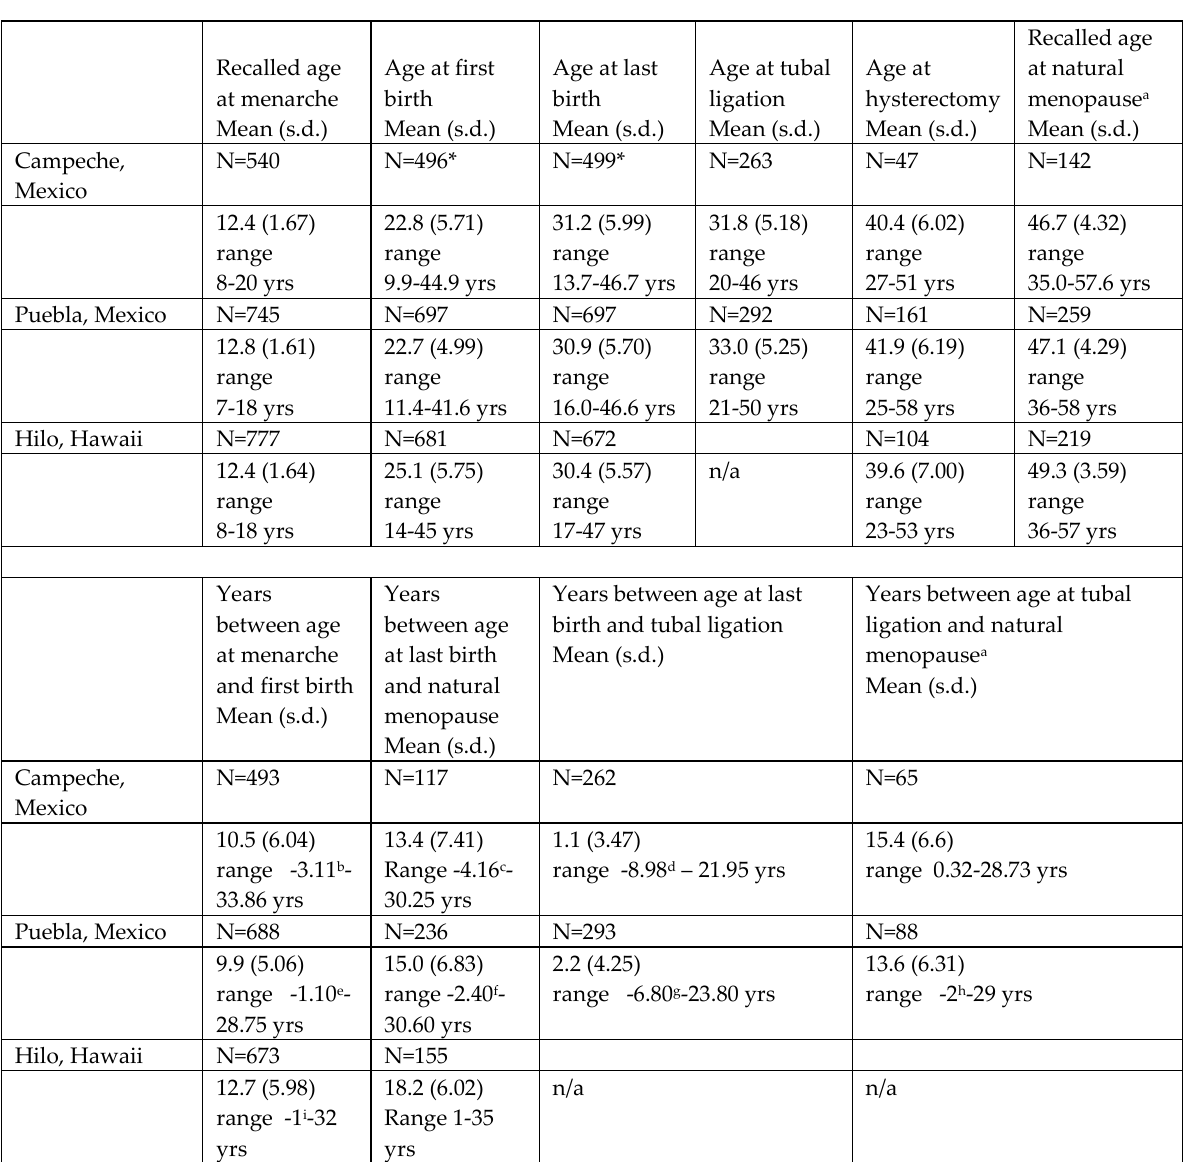
Recalled ages at menarche, first birth, last birth, tubal ligation, hysterectomy, natural menopause, and the duration of time between select